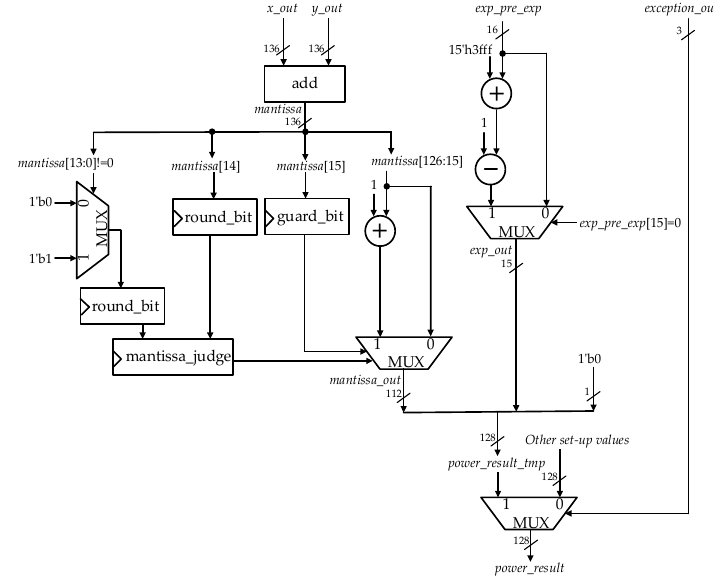
Figure 12. Architecture of the postprocessing module.